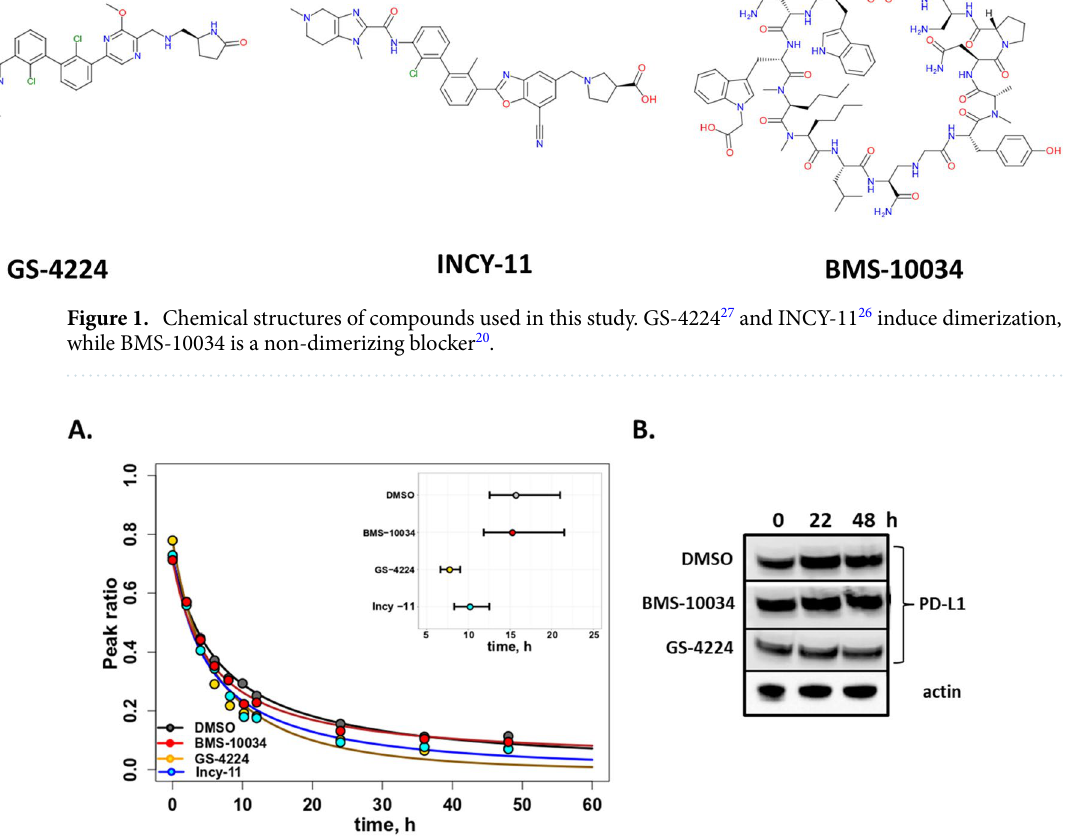
Figure 2. Overall turnover of PD-L1 protein. ( A ) Degradation of PD-L1 3xFLAG protein transfected into HEK 293 T cells measured by SILAC pulse chase method. Data for DMSO control are superimposed with those for dimer-inducing 1 μM GS-4224 and Incy-11, and 1 μM macrocyclic blocker BMS-10034. The half-life comparisons demonstrate that DMSO and BMS-10034 have half-life estimates that are not statistically